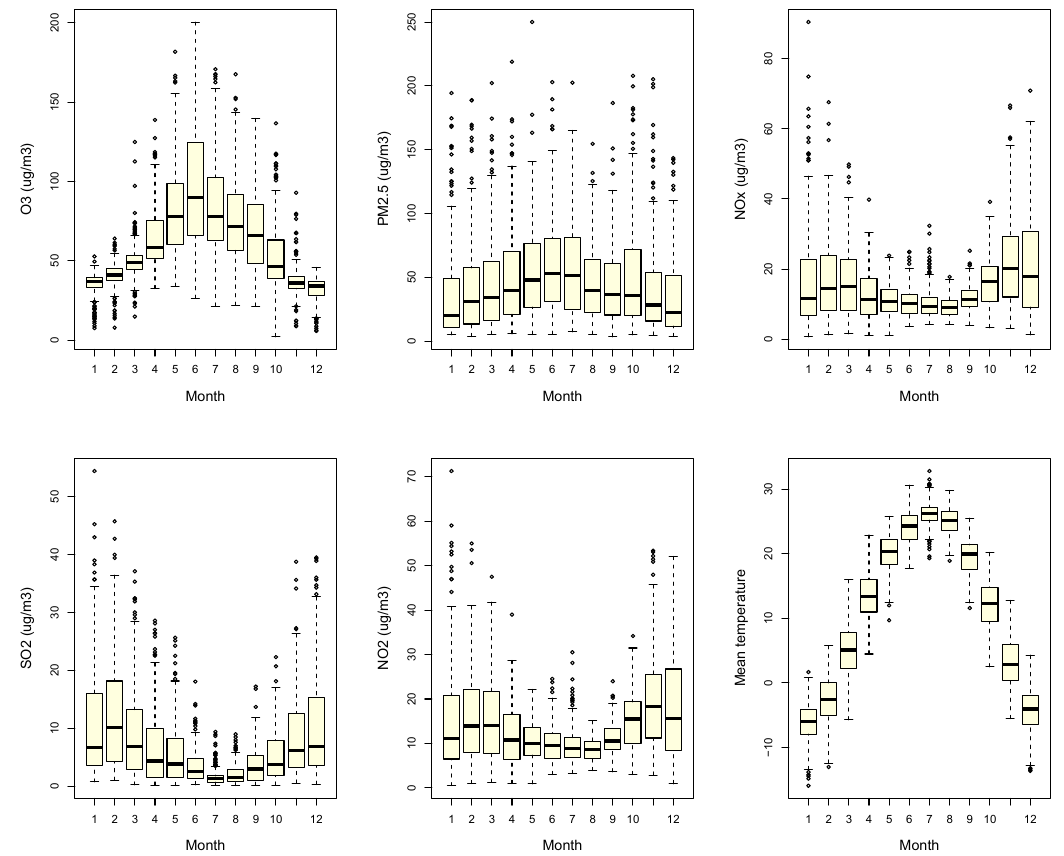
Figure 4. Monthly O 3 , NOx, NO 2 , mean temperature, SO 2 , and PM 2.5 concentration.